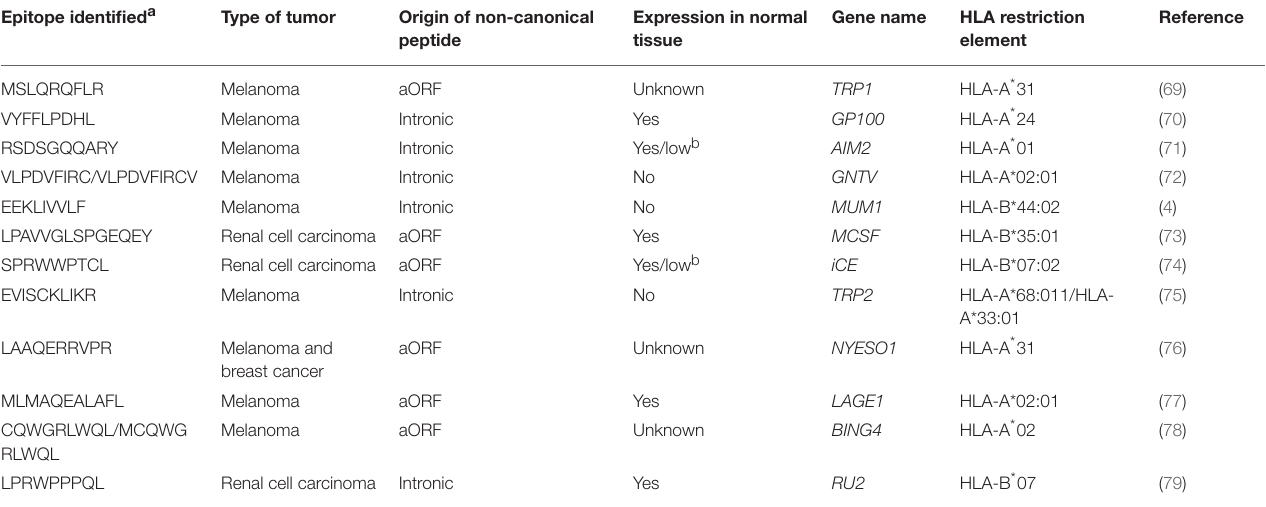
TABLE 2 | Tumor-rejection antigens derived from non-canonical protein sequences. Epitope identified